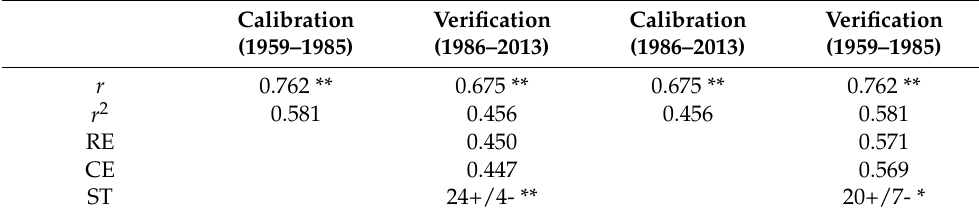
Table 2. Verification statistics for the reconstruction